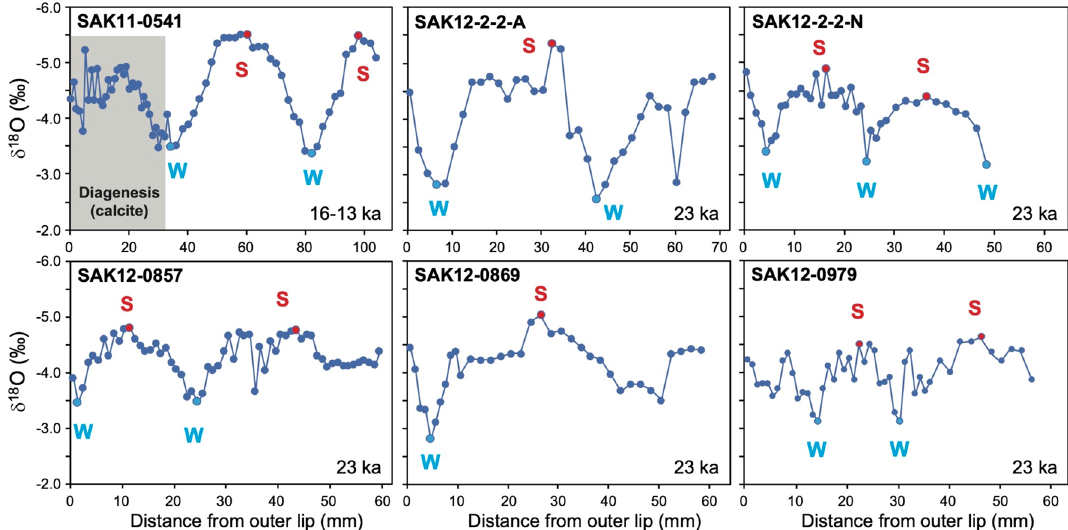
Figure 2. δ 18 O values of fossil freshwater snails showing seasonal temperature variations (S = summer; W = winter). The δ 18 O data for sample SAK11-0541 with calcite cement (shown in gray) were not used for the temperature reconstruction. Sample SAK11-0541 and the other samples were excavated from Layer I (16.1– 13.4 ka) and Layer II-2 (23.1–22.5 ka) in Sakitari Cave, respectively. The lowest and highest values in a seasonal cycle were assigned to annual maximum (red circles) and minimum (blue circles) temperatures during summer and winter, isotopic results imply that the cave water system and rainfall vapor source during the two studied periods in the last glaciation were broadly similar to those of today.